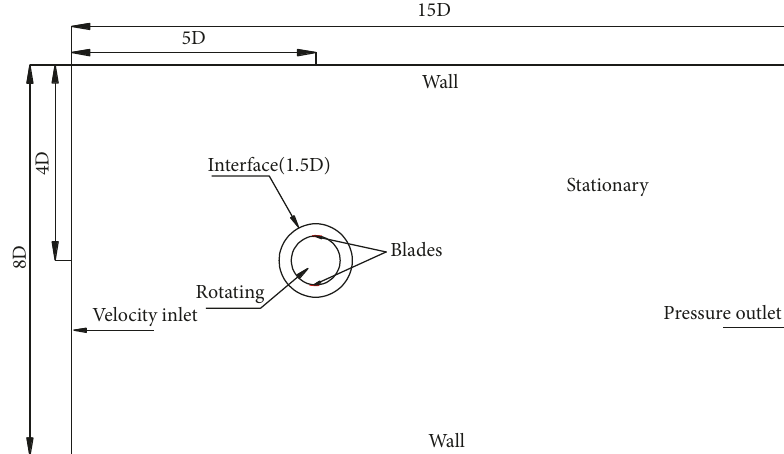
Figure 2: Computational domain and boundary conditions.